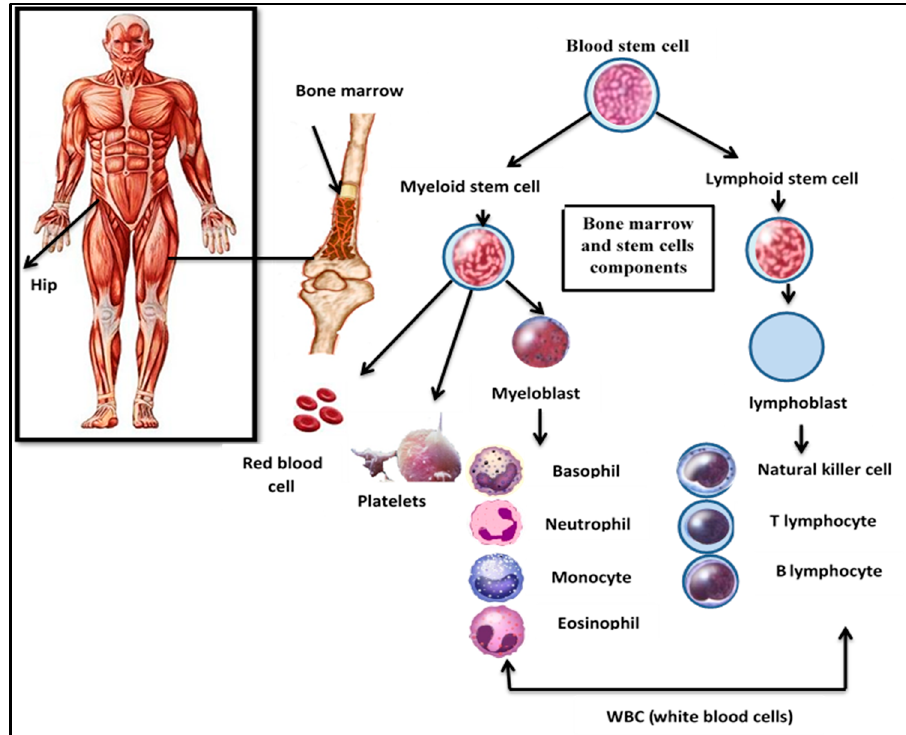
Figure 1. Bone marrow and stem cells components.